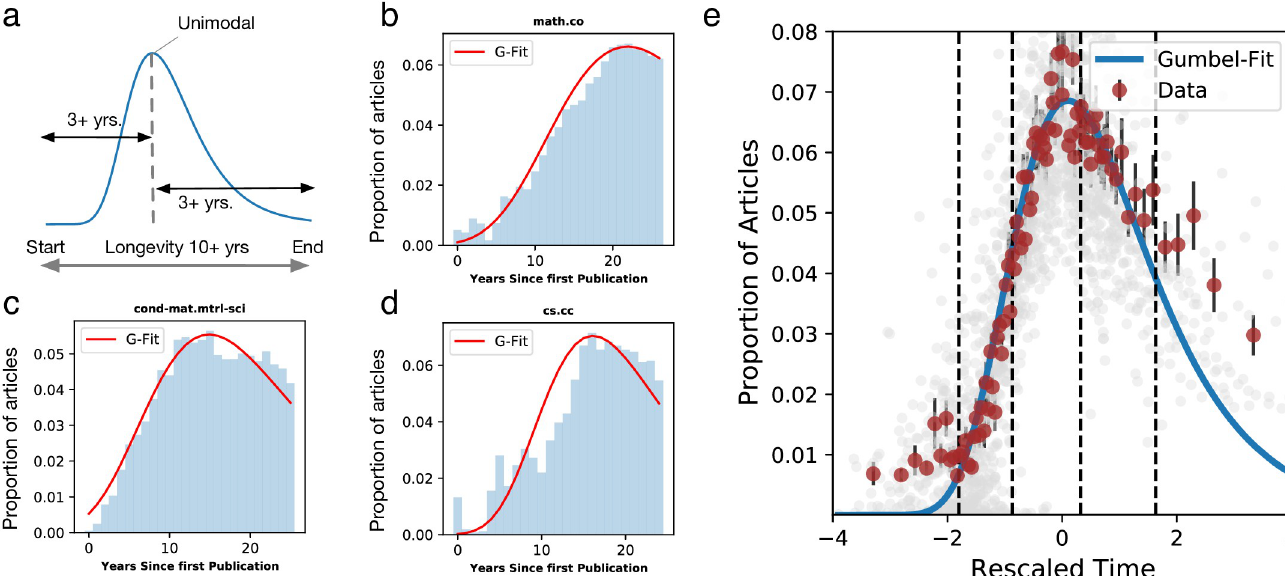
Fig 2. Temporal evolution of fields. a . Conditions for a field to be included in the analysis. b-d Gumbel fits for the fields with the largest numbers of articles in Physics, Mathematics and Computer Science: Mathematics—Combinatorics (b), Material Science (c) and Computational Complexity (d). e . Evolution of the 72 studied fields after temporal re-scaling from Eq 2. The blue curve represents the Gumbel fit, and red dots correspond to the empirical average over equal sample-size bins. Error bars indicate standard error.